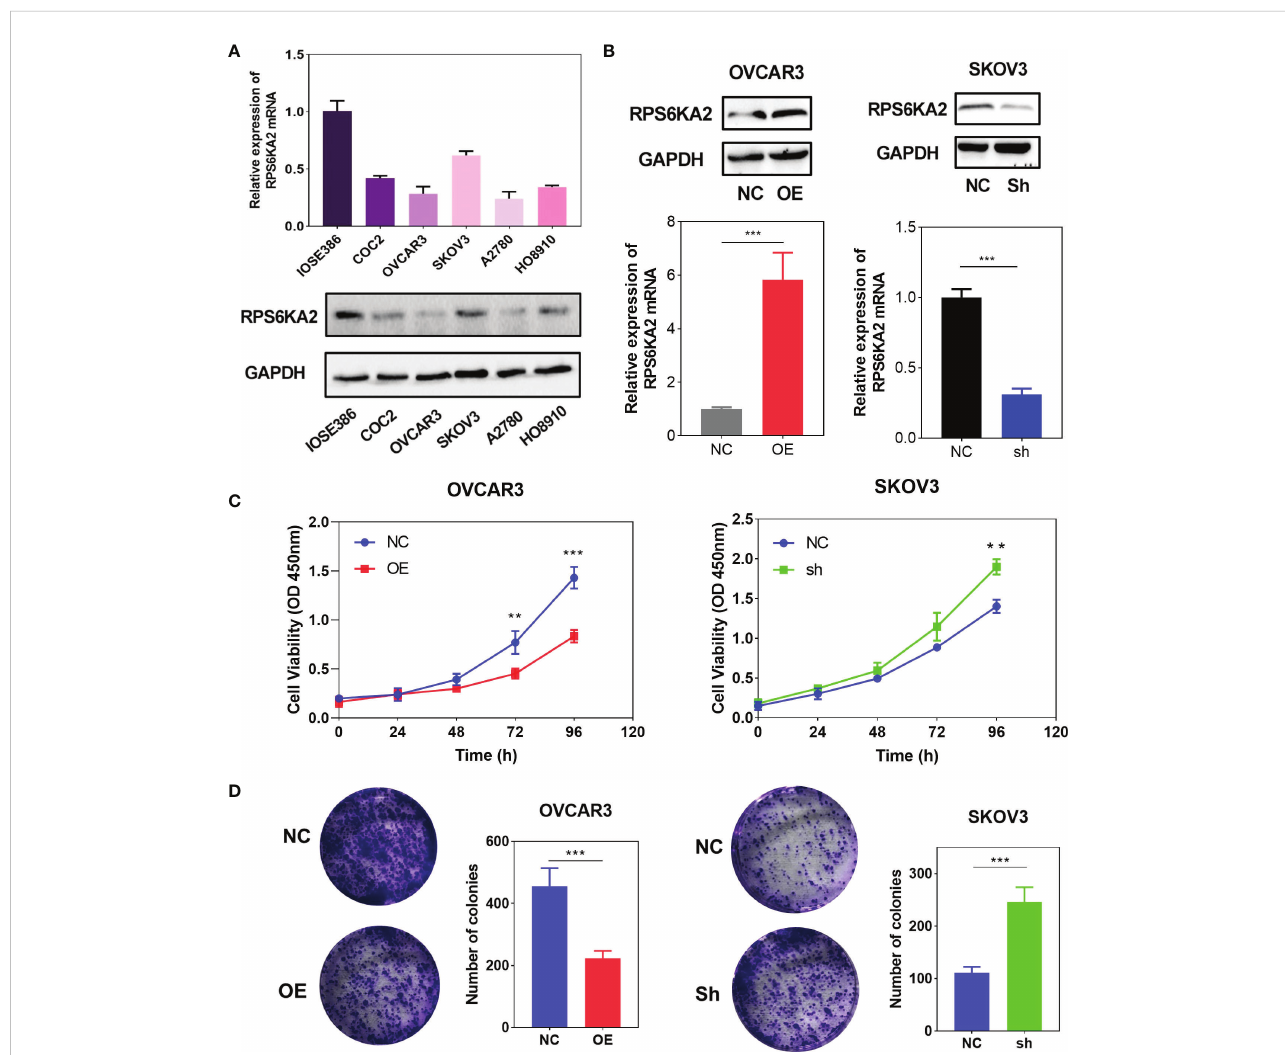
FIGURE 2 RPS6KA2 inhibited the proliferation of ovarian cancer cells. (A) The mRNA and protein expression of RPS6KA2 in the IOSE386 and ovarian cancer cell lines including HO8910, SKOV3, OVCAR3, A2780 and COC2. (B) The mRNA and protein expression levels of RPS6KA2 were examined in OVCAR3 cells transfected with OE and SKOV3 cells transfected with Sh. (C) The proliferation of RPS6KA2 overexpressed and knockdowned ovarian cancer cells was measured by CCK-8 assay. (D) The colony formation was assessed in ovarian cancer cells and statistical signi fi cance was analyzed based on the numbers of colonies.(** indicates p<0.01, *** indicates